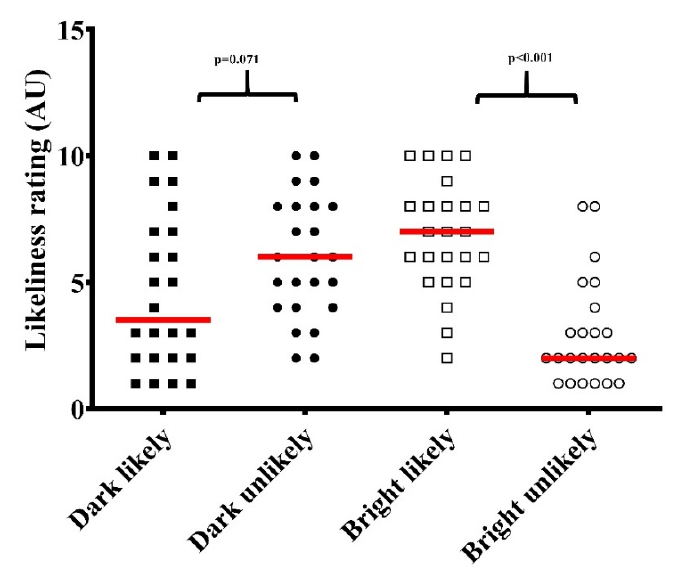
Figure 2. Ratings of bright and dark ball likely and unlikely test event outcomes. Data are presented as grouped dot plots and medians. AU = arbitrary